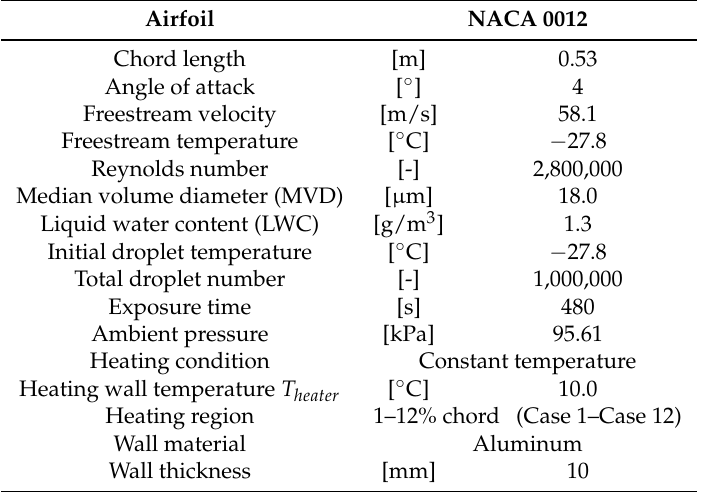
Table 2. Numerical conditions for NACA 0012 [38].